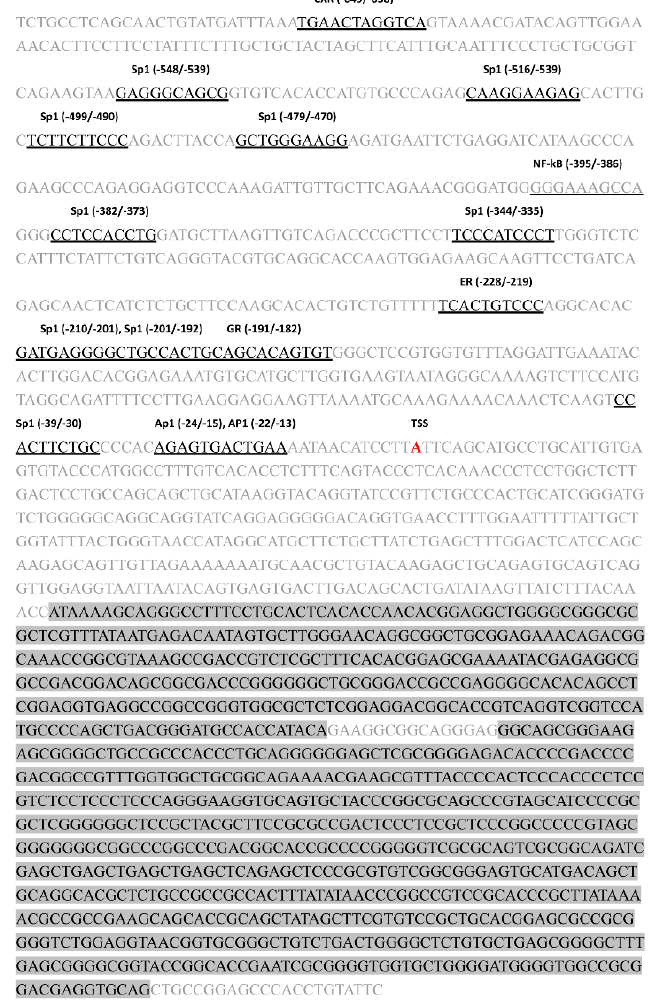
Figure 1. Nucleotide sequence of the promoter region ( − 1071 to + 1339) of the chicken Abcb1 gene. The transcriptional start site (TSS) was designated + 1. The putative binding sites for the transcription factors were predicted using the AliBaba2.1 database and marked by underlining that part of the sequence. The CpG islands were predicted by MethPrimer and marked with a gray background.